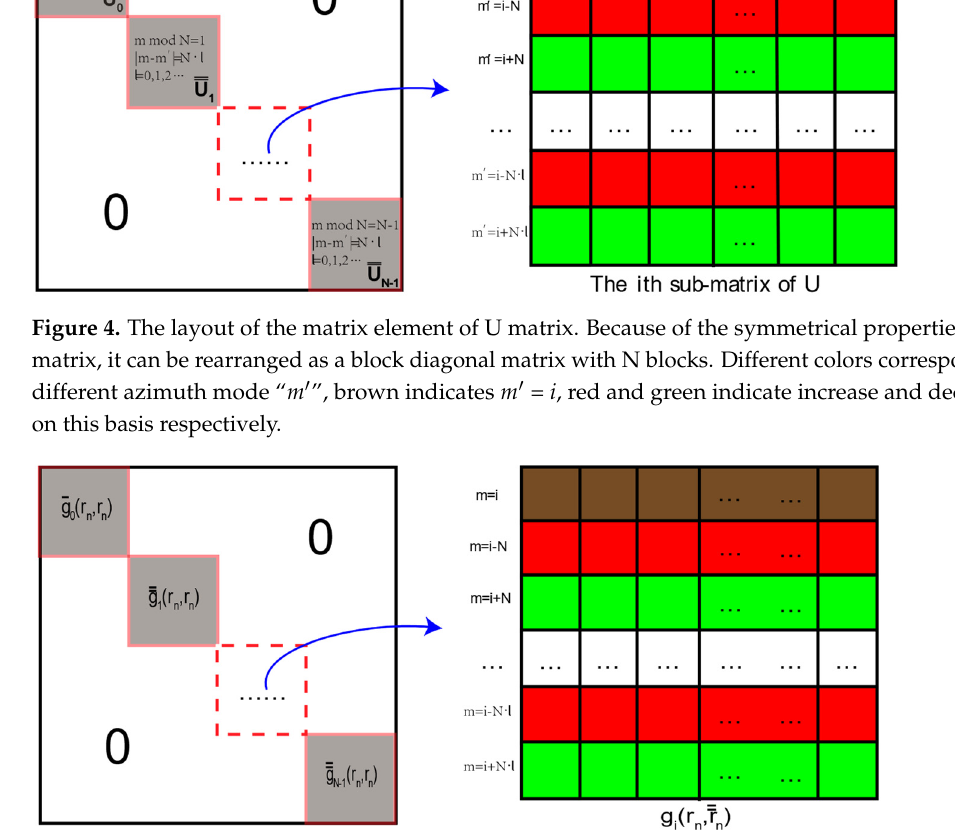
Figure 4. The layout of the matrix element of U matrix. Because of the symmetrical properties of U matrix, it can be rearranged as a block diagonal matrix with N blocks. Different colors correspond ′ ′ ”, brown indicates m = i , red and green indicate increase and de- to different azimuth mode “ m crease on this basis respectively.